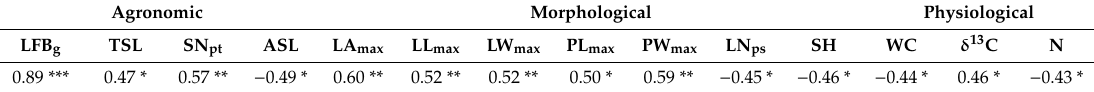
Table 3. Pearson’s correlation coe ffi cients for the relationship between SFB (shoot fresh biomass) and agronomic, morphological and physiological traits of eight mulberry cultivars. Asterisks indicates the level of significance as *: p < 0.05, **: p < 0.01 amd ***: p < 0.001. LFB g : leaf fresh biomass of growing shoots, TSL: total shoot length, SN pt : shoot number per tree, ASL: average shoot length,